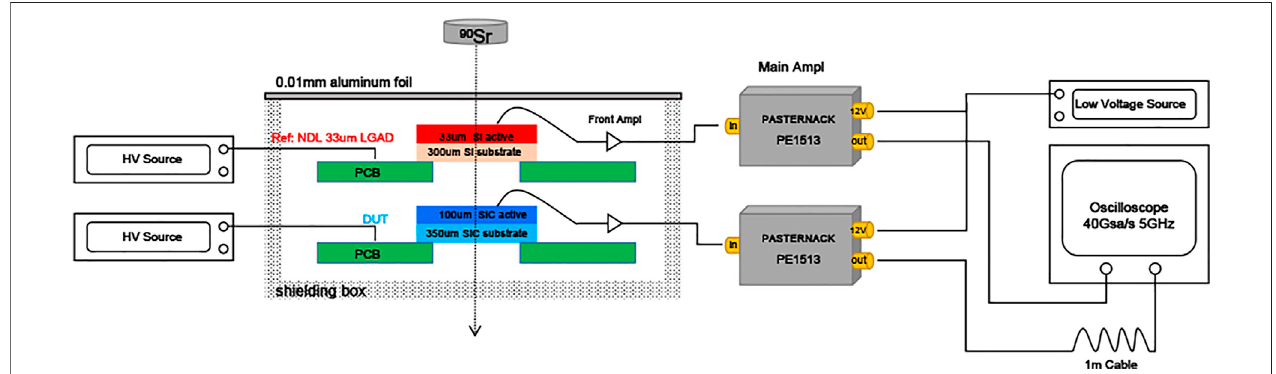
FIGURE 4 | Schematic diagram of the β source test system to measure the time resolution. A 33 μ m NDL Si-LGAD is used as a reference for timing. The front ampli fi er and main ampli fi er have 100 times to the input signal. Another 1 m cable connects with the output of the main ampli fi er to delay the DUT signal.